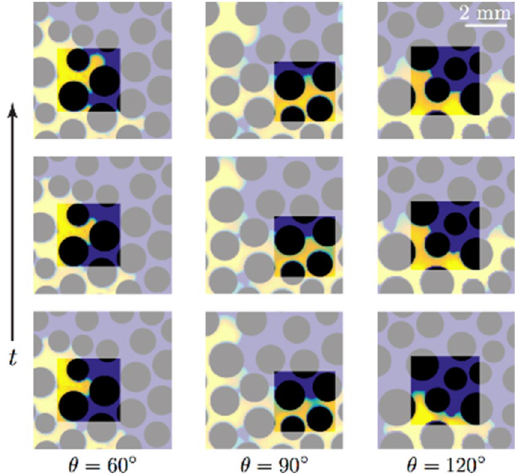
Figure 5. Experimental sequences of snapshots as the invading fluid traverses through a converging-diverging pore throat under different wettability conditions (left to right: θ = 60°, 90°, 120°). The experiments were conducted in a quasi-2D micromodel patterned with cicular posts (black) at low Ca, such that capillary forces dominate viscous forces. Here, the invading fluid (yellow) is water and the defending fluid (blue) is silicone oil. For θ = 90° (center column), the fluid-fluid interface curvature reverses from being convex in the converging section of the pore throat to being concave in the diverging section of the pore throat. In contrast, the fluid-fluid interface remains concave for θ = 60° (left column) and convex for θ = 120° (right column) through the invasion